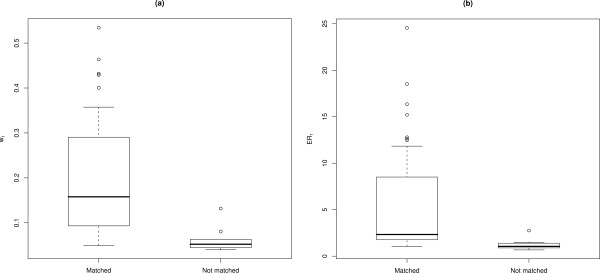
Automated versus by-eye matching results. Box-and-whisker plots of (a) IC weights (w1) for by-eye matched images that were matched and not matched using I3S; (b) Evidence ratios (ER1) for by-eye matched images that were matched and not matched using I3S. Central tendency (black horizontal line) indicates the median, and whiskers extend to 0.5 of the inter-quartile range.